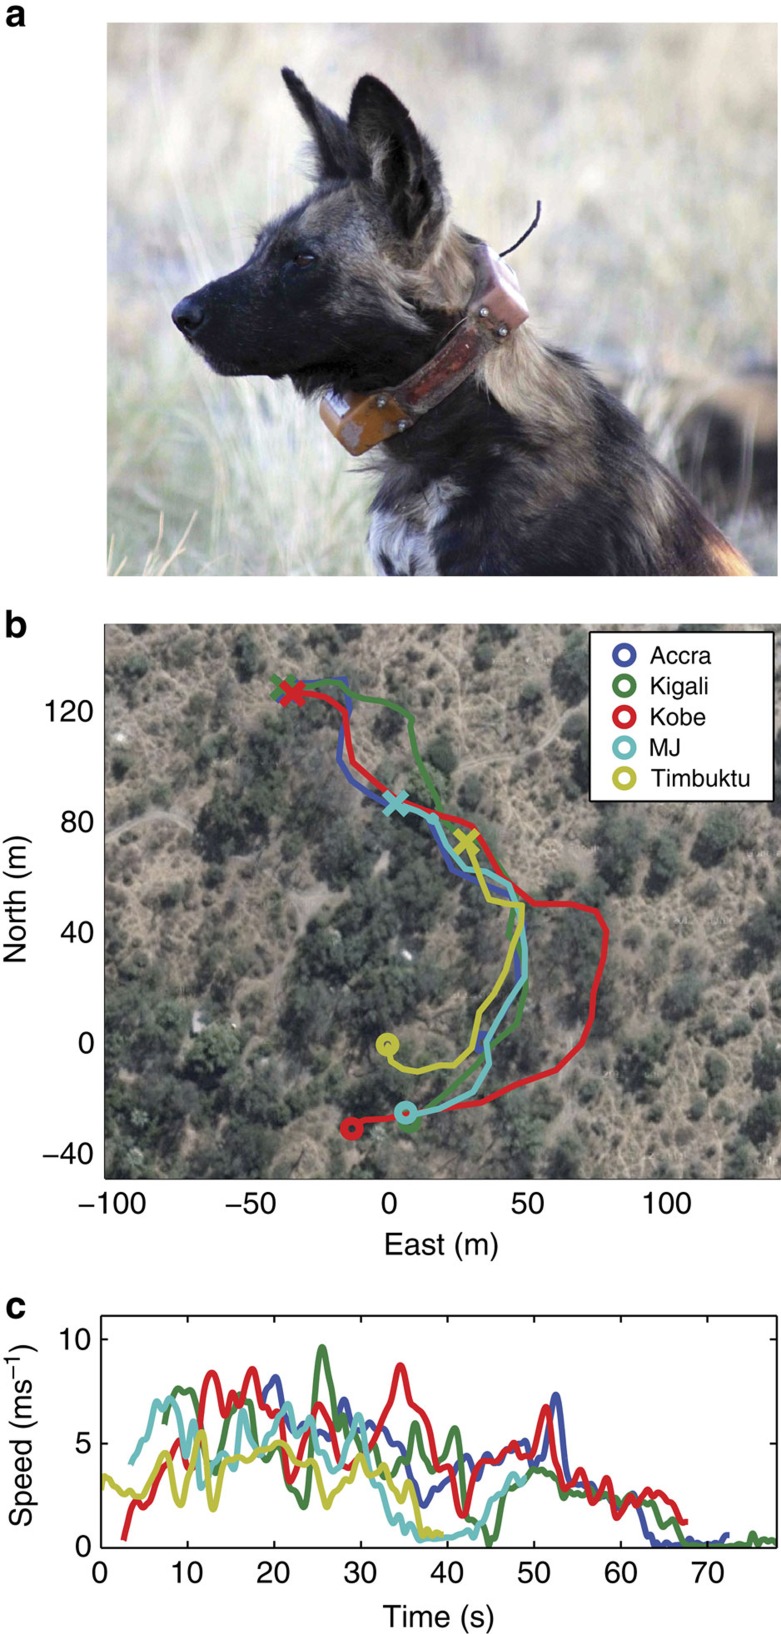
GPS collar and traces.(a) African wild dog with collar. (b) Example GPS trace for unsuccessful MDC involving five individuals, origin at MDC start position, run start (circle) and run end (cross). (c) Speed profile for each dog in b.